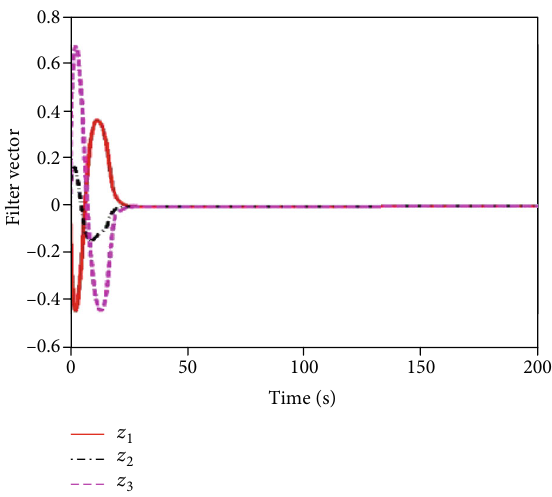
Figure 15: Time histories of angular velocities in Case 3 when k ð 0 Þ = 0 : 5 .